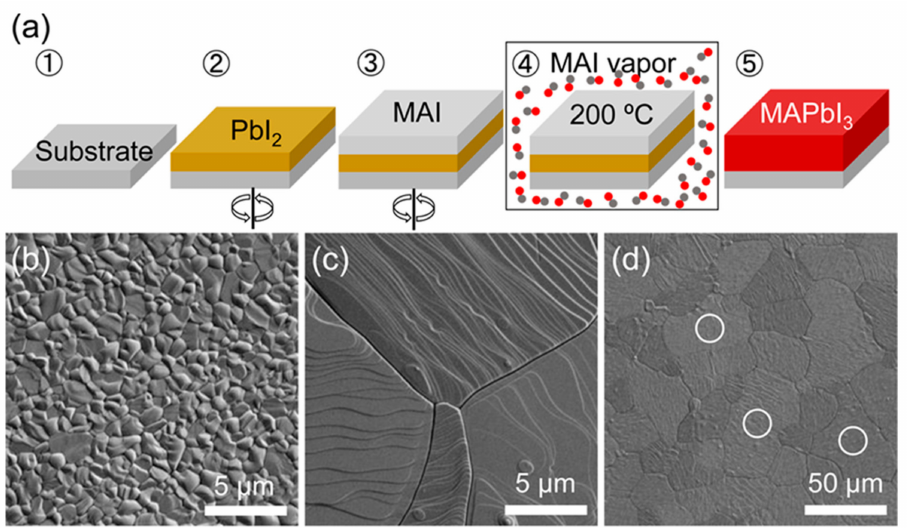
Figure 15. ( a ) Schematic of process of vapor assisted large crystal growth and ( b – d ) SEM of the film after treatment with different time. Reproduced with permission from Ref.